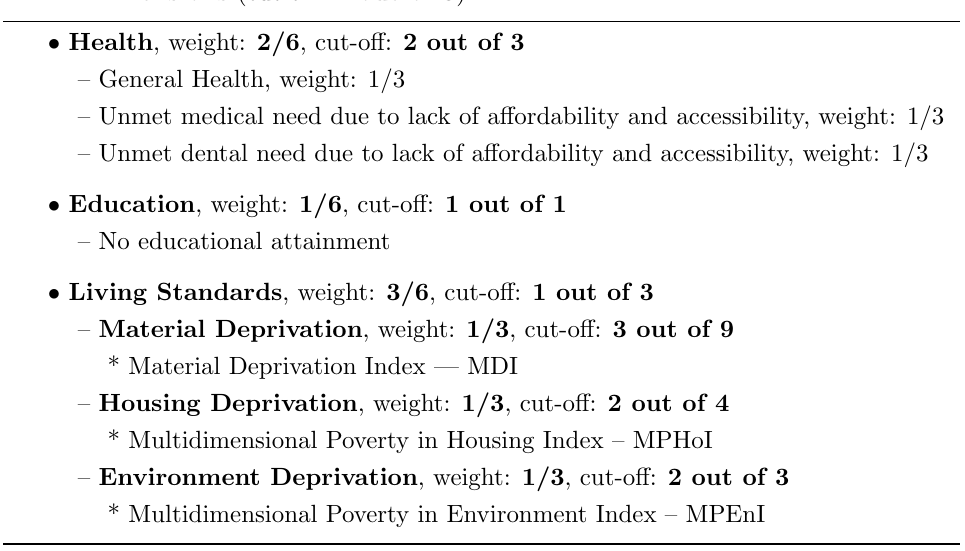
Table 2: MPI dimensions and indicators, including their weights and cut-offs (Weziak- Bialowolska, Dijkstra 2014) MPI Dimensions (cut-off: 2 out of 3